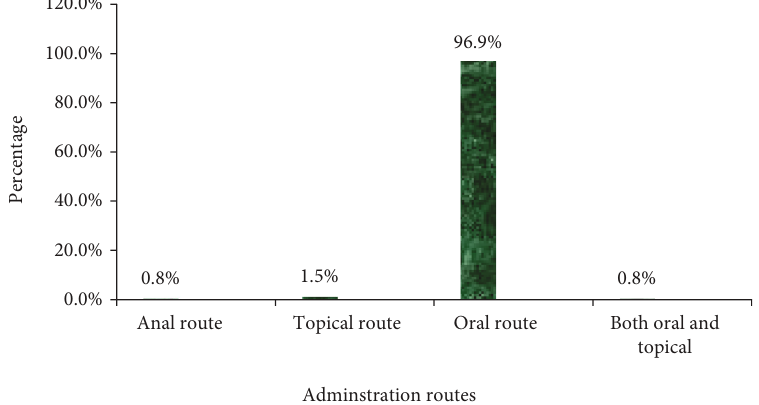
Figure 7: Route of administration of medicinal plants used for the treatment of intestinal parasitosis.